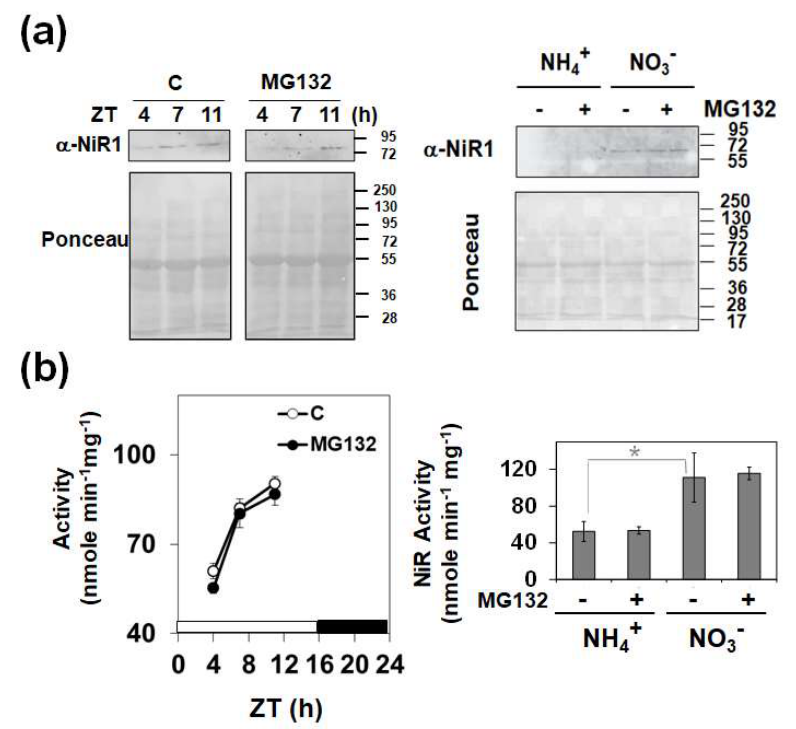
Figure 5. Effect of proteasome-mediated degradation on light- and nitrate-induced NiR1 protein and enzyme activity. ( a ) NiR1 protein levels and ( b ) NiR1 activity in long day-photoperiodic conditions for 11 days and collected either at the indicated Zeitgeber time (ZT) during the light phase (left panels) or by growing for 9 days in ammonium-supplied media and then transferred to media containing either 10 mM nitrate (NO 3− ) or 5 mM ammonium (NH 4+ ), as indicated, for two additional days (right